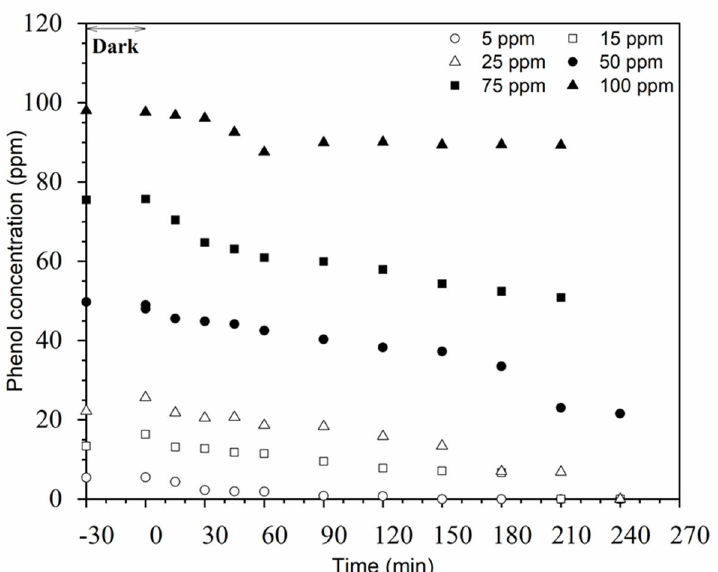
Figure 7. Effect of initial phenol concentration (m POF/TiO2 = 50 mg; c POF/TiO2 = 1 g/L, λ = 254 nm; V phenol = 50 mL; pH = 6.7).